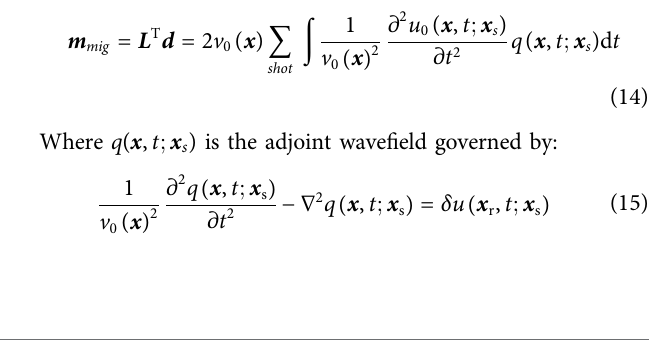
Frontiers in Earth Science |